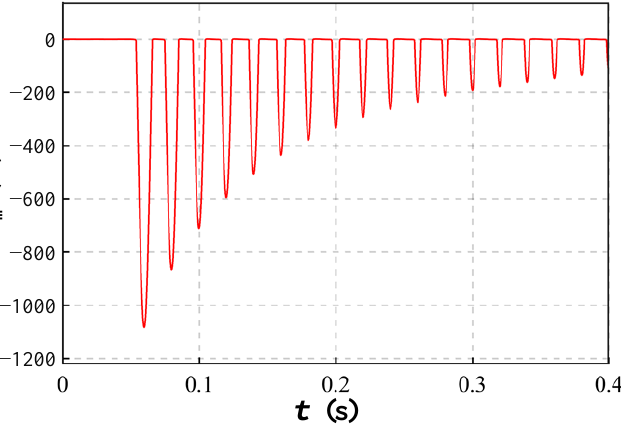
Figure 12. Magnetizing inrush current waveforms on the primary side of vehicle-mounted trans- former closing at 0° (Φ r = 0.7 pu).